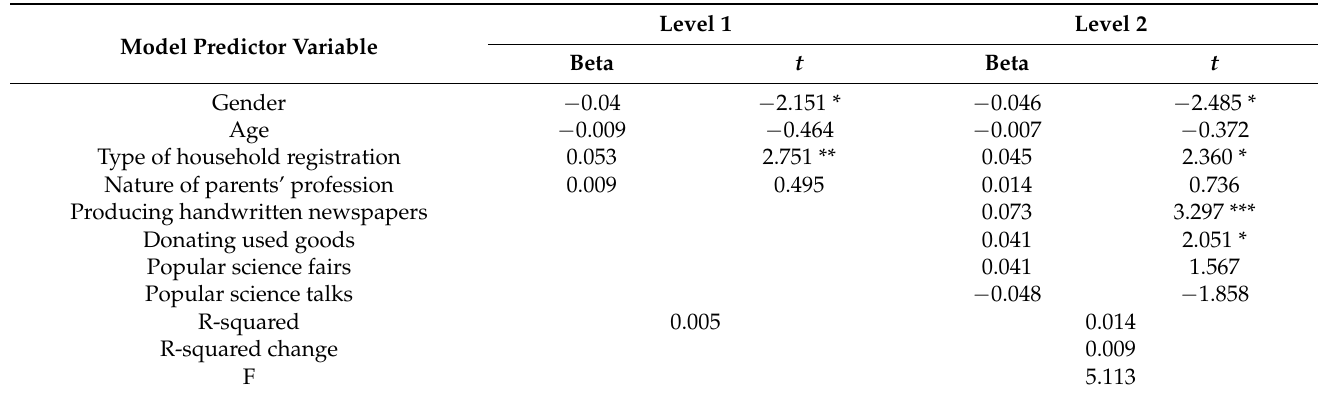
Table A5. Regression analysis of the effects of four types of climate change knowledge on preferred hours of instruction.